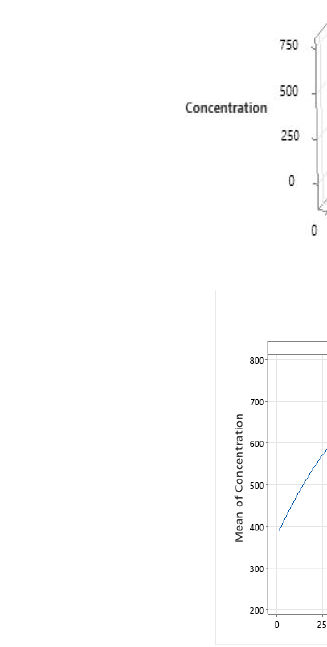
Figure 2. ( a ) Multiple response prediction analysis; ( b ) Surface plot of UA concentration (µg/mL) cv time (h) and temperature (°C).